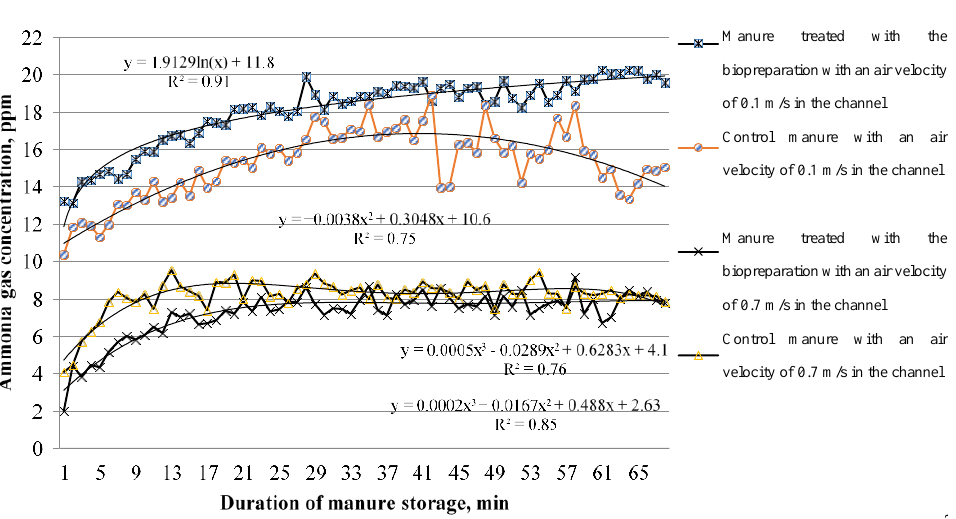
biopreparation in the tunnel, depending on manure storage time 35.